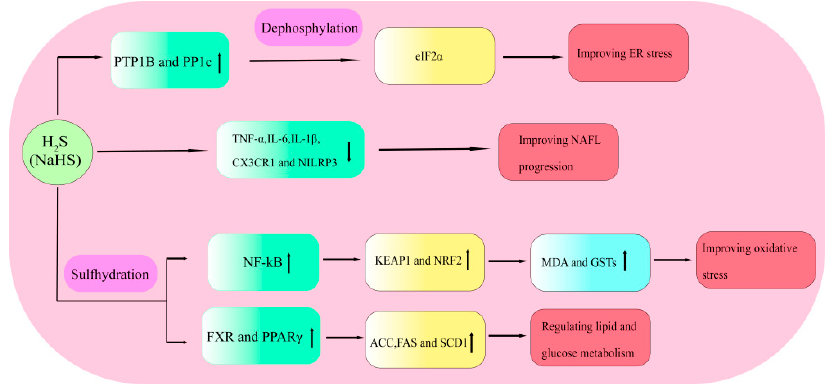
Figure 4. H 2 S alleviates NAFLD by improving inflammation, oxidative stress, lipid and glucose metabolism, and ER stress. Upward arrows indicate up-regulation of gene expression.